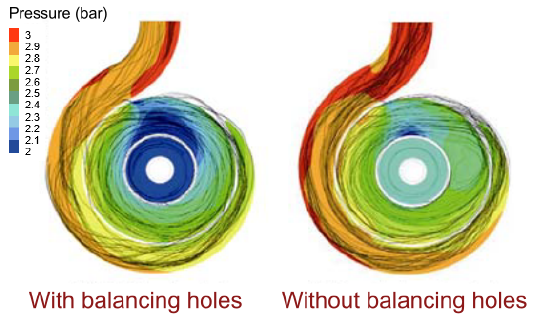
Figure 20. Difference in streamlines and pressure contours for impeller with and without balancing holes. Reproduced from [56],